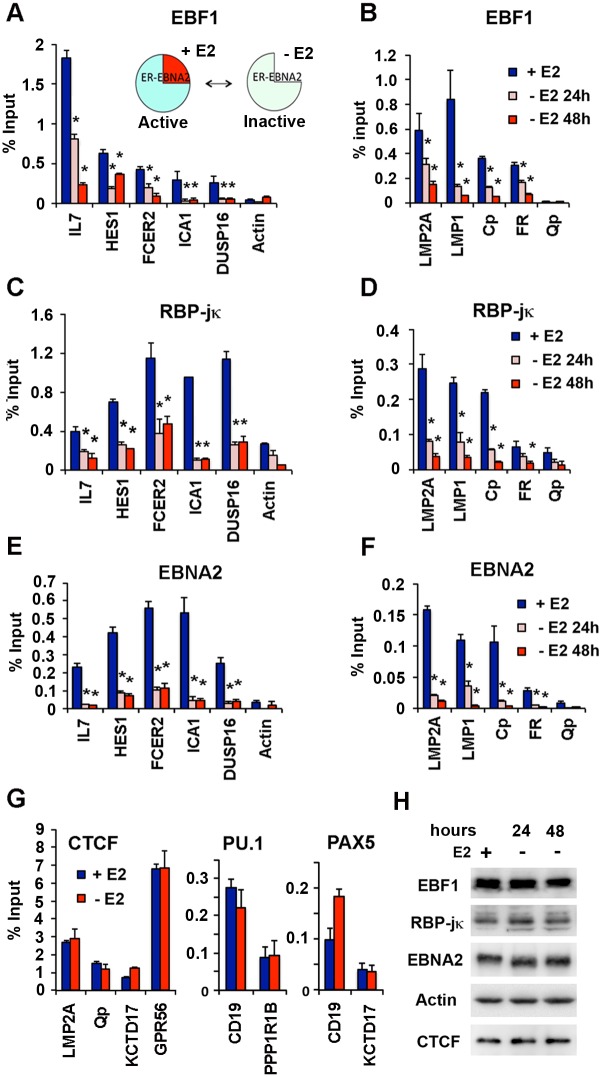
EBNA2-dependent transcription factor redistribution in chromatin occupancy.EREB2.5 cells were treated with (+) or without (-) estradiol (E2) for 24 or 48 hrs and then assayed by ChIP for binding to EBF1 (A and B), RBP-jκ (C and D), or EBNA2 (E and F) at cellular (A, C, E) or EBV genome sites (B, D, F). Actin genomic region (cellular) or Qp (EBV) was used as negative binding control for EBF1, RBP-jκ, ορ EBNA2 ChIP. (G) ChIP binding for CTCF, PU.1, or PAX5 in EREB2.5 cells treated (blue) or untreated (red) with E2 for 48 hrs. PPP1R1B or KCTD17 genomic region was negative binding control PU.1 or PAX5, respectively. Asterisk indicates p < 0.05. (H) Western blot showing protein levels for EBF1, RBP-jκ, EBNA2, Actin, and CTCF in EREB2.5 cells at 24 and 48 hrs after E2 withdrawal.